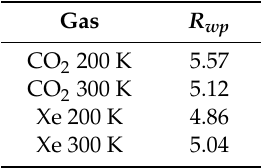
Table 2. Weighed profile R factor of Rietveld refinement performed on Y zeolite